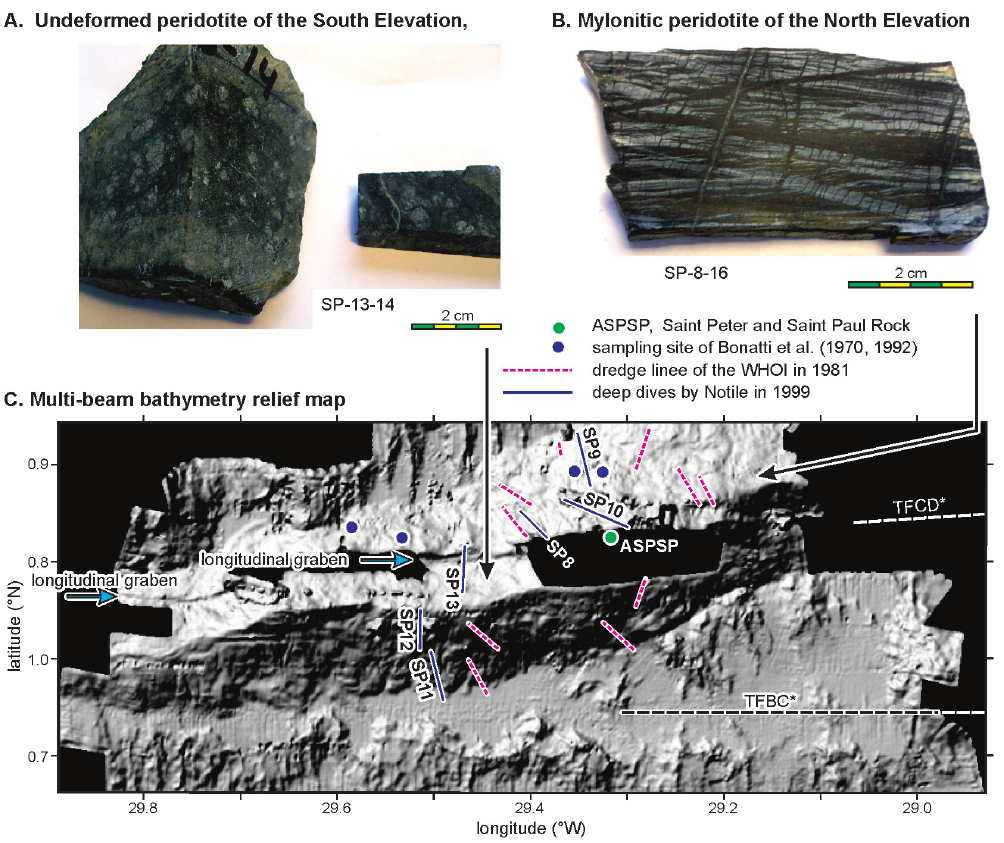
Figure 5 - Abyssal mantle peridotite collected from the deep dives (A, B) and the sampling trajectories (C) . The relief map shows multi-beam bathymetry around the Saint Peter and Saint Paul Peridotite Ridge. The figure is modified from Sichel et al.